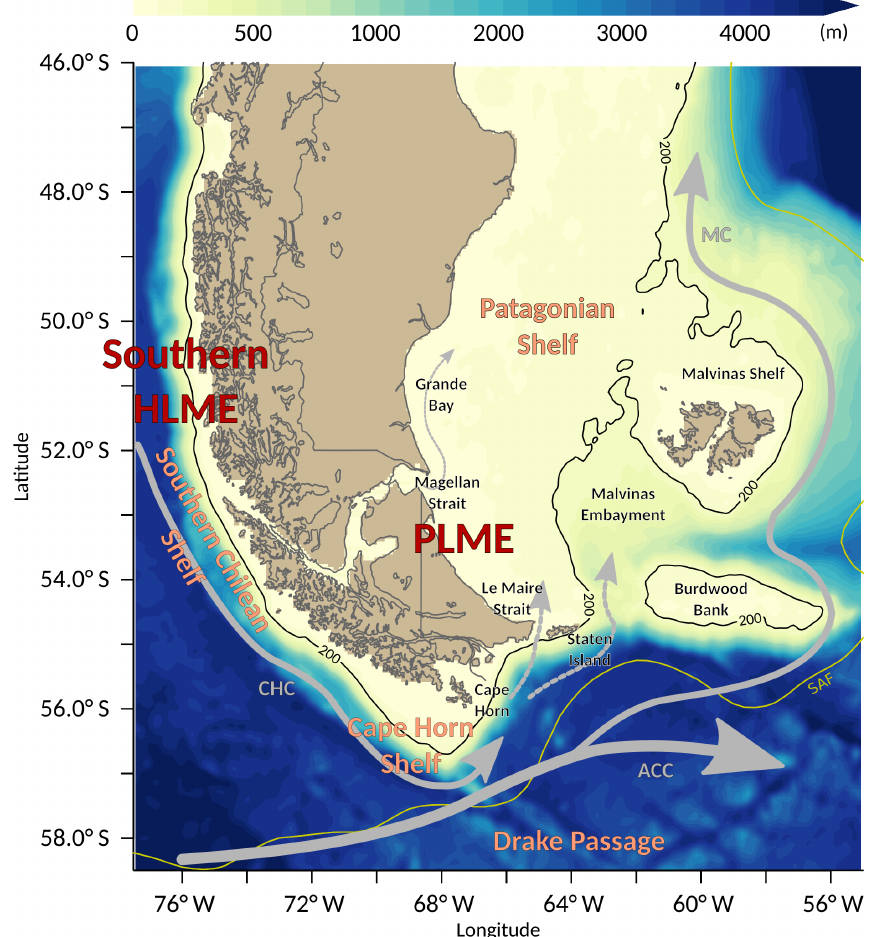
Figure 1. Domain of study and main geographic features. The colors show the bathymetry (m) of the CMM model used in this study. The northern branch of the Antarctic Circumpolar Current (ACC), the Cape Horn Current (CHC), and the Malvinas Current (MC) paths are shown in grey, and the southern Subantarctic Front (SAF), as defined by Kim and Orsi (2014), is shown in